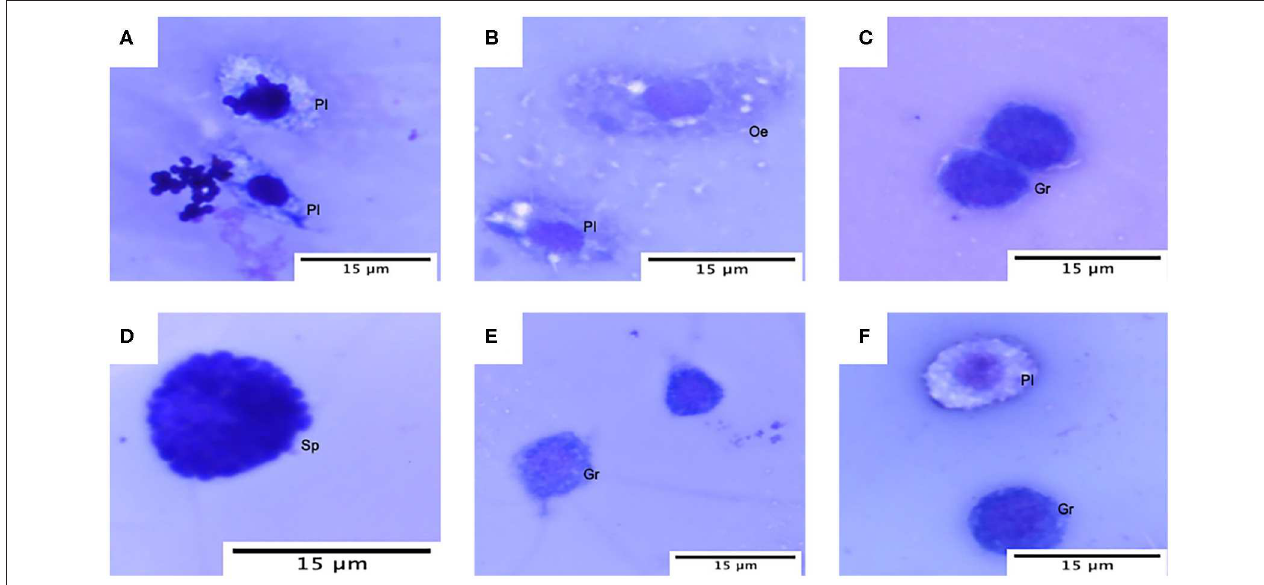
FIGURE 4 | Hemocytes of G. mellonella under the light microscope. (A) Plasmatocytes (Pl) with M. furfur yeast; (B) oenocyte (Oe) and plasmatocyte (PI); (C) granulocyte (Gr); (D) spherulocyte (Sp); (E) granulocyte and prohemocyte (Pr); and (F) plasmatocyte and granulocyte.